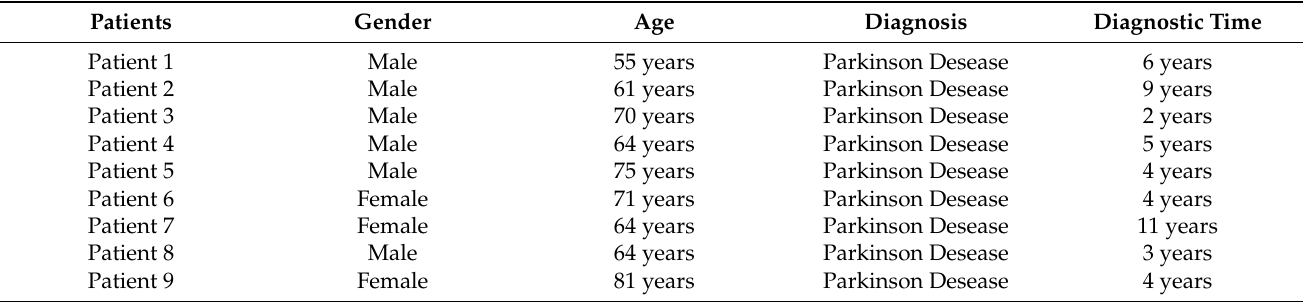
Table 1. Description of the study population.